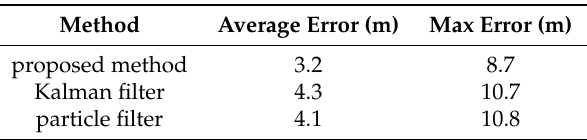
Table 2. The average and maximum positioning error comparisons if 5% of outliers in Wi-Fi fingerprinting are added.